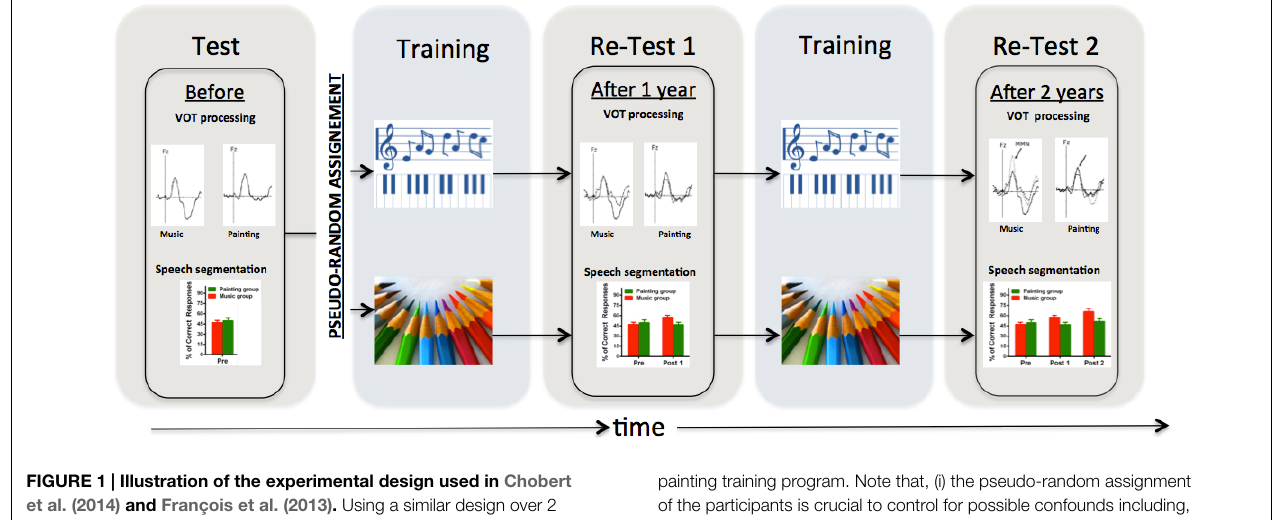
FIGURE 1 | Illustration of the experimental design used in Chobert et al. (2014) and François et al. (2013). Using a similar design over 2 school years with test-training-retest-training-retest procedure over 2 years, 8-year-old children who followed a musical training program exhibited behavioral and electrophysiological evidence of increasing VOT processing and speech segmentation skills than children who followed a